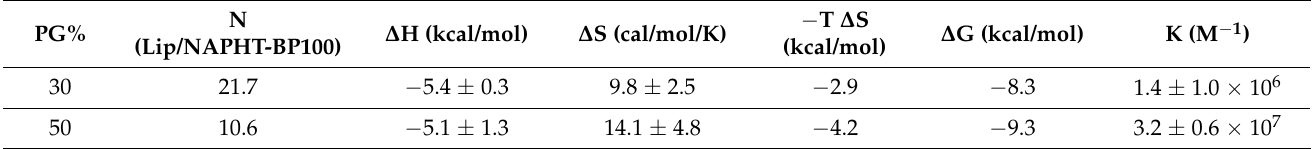
Figure 5. NAPHT-BP100 lipid binding by calorimetry. ( A ) Heat variation per second during titration of an NAPHT-BP100 peptide solution with a POPC:POPG (50:50) LUV suspension. ( B ) Integrated heat per mole of lipid at each injection as a function of lipid/peptide molar ratio. Measurements were performed at 25 ◦ C, loading a 3–6 mM LUV suspension in the syringe and titrating a 40 µ M peptide solution in 10 mM Tris-HCl buffer, pH 7.4. Table 3. Thermodynamic parameters of NAPHT-BP100-lipid